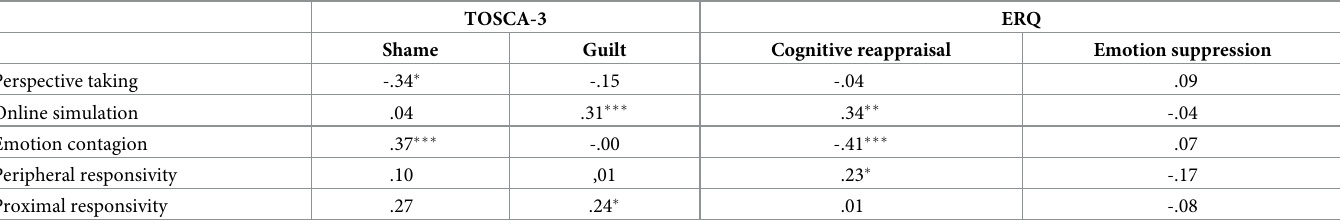
Table 4. Standardized path coefficients for the predictions of the dimensions of shame and guilt, and cognitive reappraisal & emotion suppression by the dimen- sions in the QCAE ESEM-5